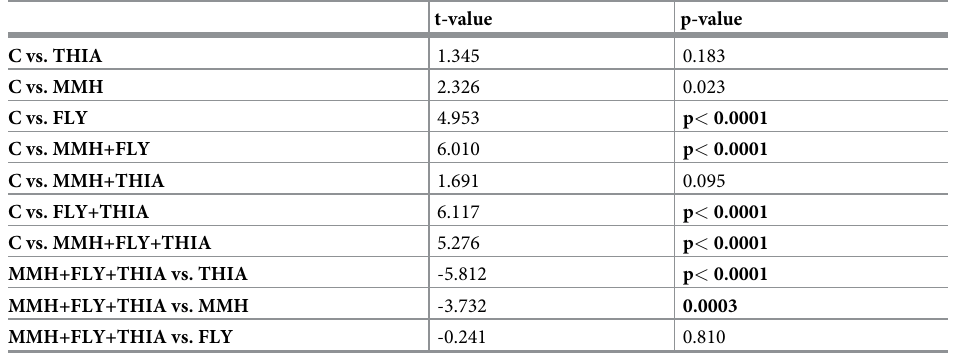
Table 2. Pairwise differences in feed quantity ingested by honeybee workers between diets inoculated with thiaclo- prid and E . faecalis . t-value p-value C vs. THIA 1.345 0.183 C vs. MMH 2.326 0.023 C vs. FLY 4.953 p < 0.0001 C vs. MMH+FLY 6.010 p < 0.0001 C vs. MMH+THIA 1.691 0.095 C vs. FLY+THIA 6.117 p < 0.0001 C vs. MMH+FLY+THIA 5.276 p < 0.0001 MMH+FLY+THIA vs. THIA -5.812 p < 0.0001 MMH+FLY+THIA vs. MMH -3.732 0.0003 MMH+FLY+THIA vs. FLY -0.241 0.810 MMH, E . faecalis strain MMH594; FLY, E . faecalis strain FLY1; THIA, thiacloprid; MMH+FLY, a mixture of both bacterial strains; MMH+THIA, thiacloprid mixed with the bacterial strain MMH594; FLY+THIA, thiacloprid mixed with the bacterial strain FLY9; MMH+FLY+THIA, a mixture of all three components; C, control; ANOVA post hoc test with Bonferroni corrected alpha-level of 0.005, n = 1341 bees in total after 11 days (THIA n = 167, MMH n = 164, FLY n = 169, CONTROL n = 157, MMH+THIA n = 161, FLY+THIA n = 173, MMH+FLY n = 175, MMH +FLY+THIA n =